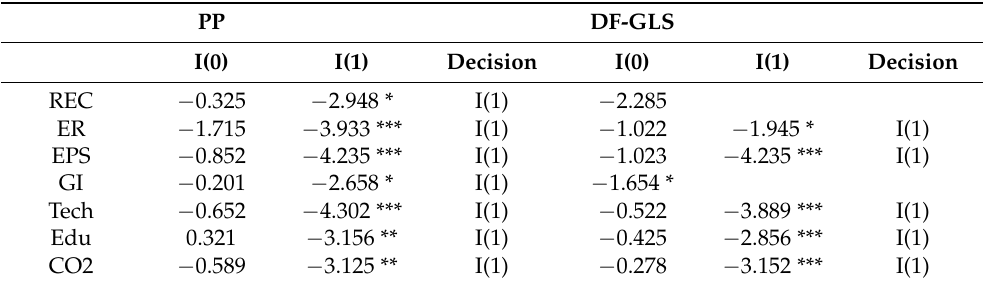
Table 2. Unit root